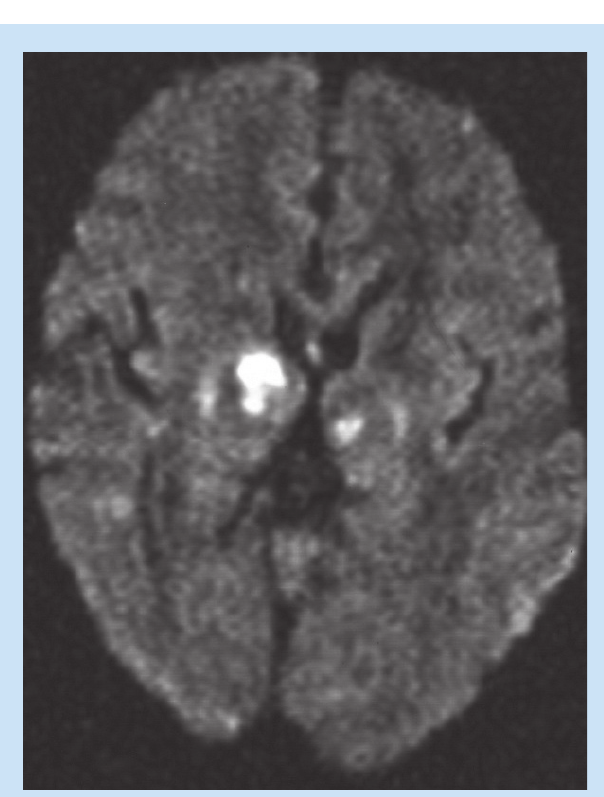
Fig. 3. Axial diffusion-weighted image with bilateral high signal intensity in the